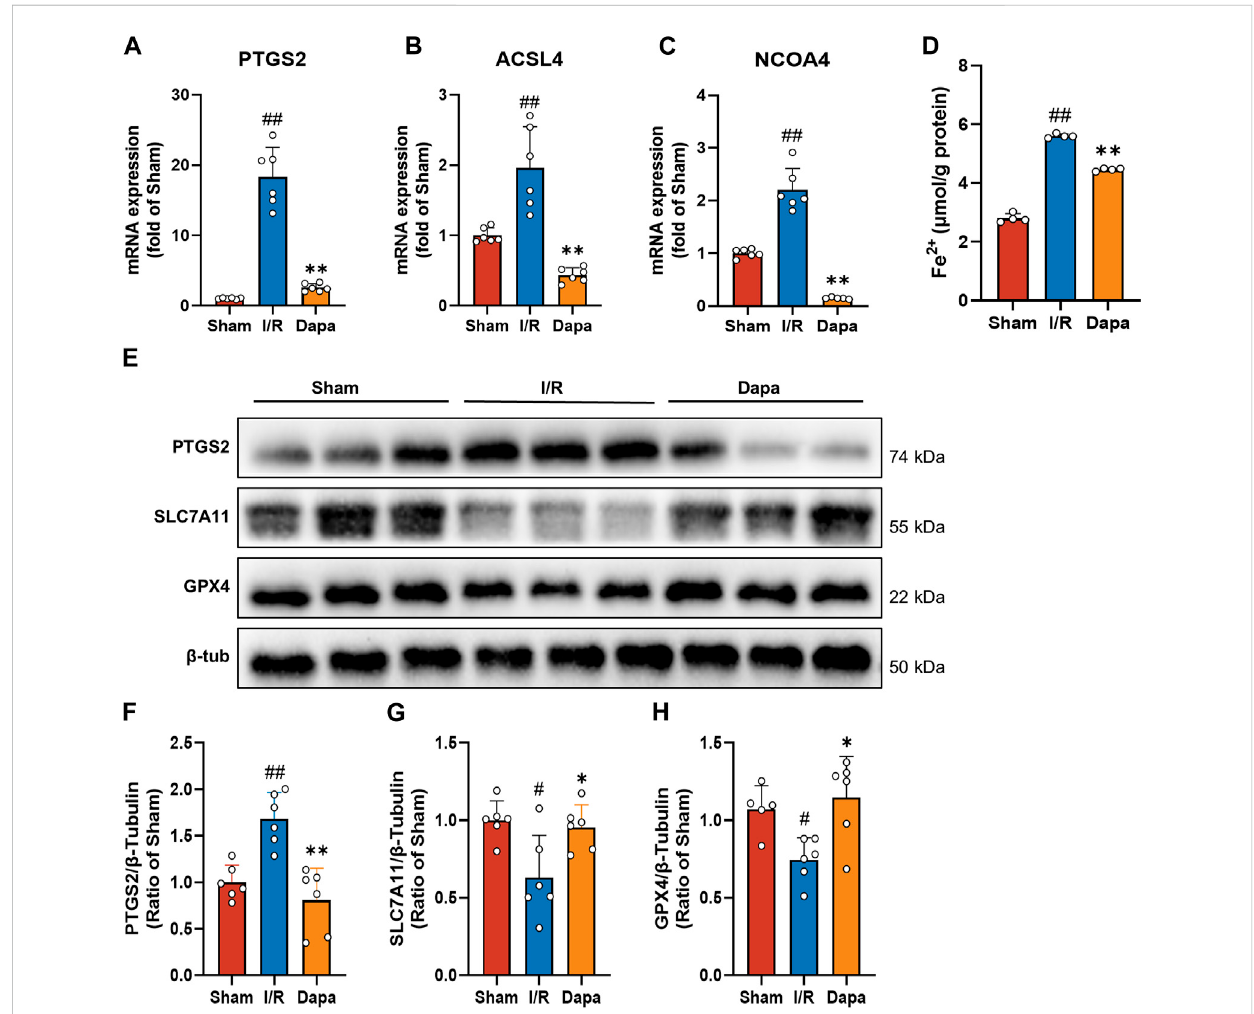
FIGURE 6 Dapagli fl ozinattenuatesI/R-mediatedferroptosis. (A – C) ThemRNAlevelsofPTGS2,ACSL4andNCOA4weremeasuredbyqPCR( n =6pergroup). (D) Ferrous iron levels in myocardial tissue were determined by a commercial kit ( n = 4 per group). (E – H) Myocardial tissue protein levels of PTGS2, SLC7A11 and GPX4 were measured by western blotting ( n = 6 per group).; Data are expressed as mean ± SD; One-way ANOVA followed by Tukey ’ s correctionfor posthoc multiplecomparisonsorDunnett ’ smultiplecomparisontests;# p < 0.05,## p < 0.01 vsShamgroup;* p < 0.05,** p < 0.01vs I/R